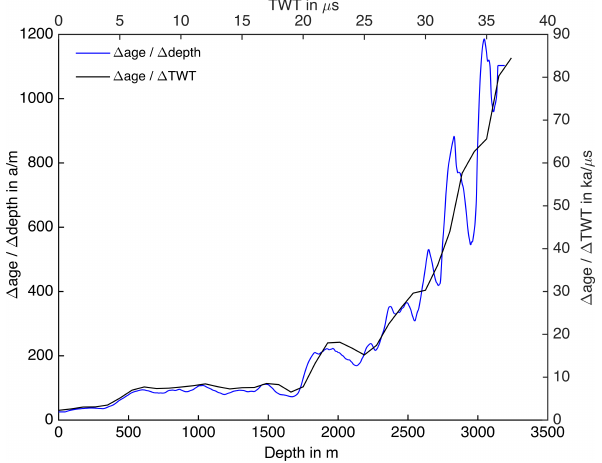
Figure 5. Gradient of the age from the AICC2012 age scale with depth (blue, left and bottom axes) and TWT (black, right and top axes) to infer age uncertainties due to reflector width and